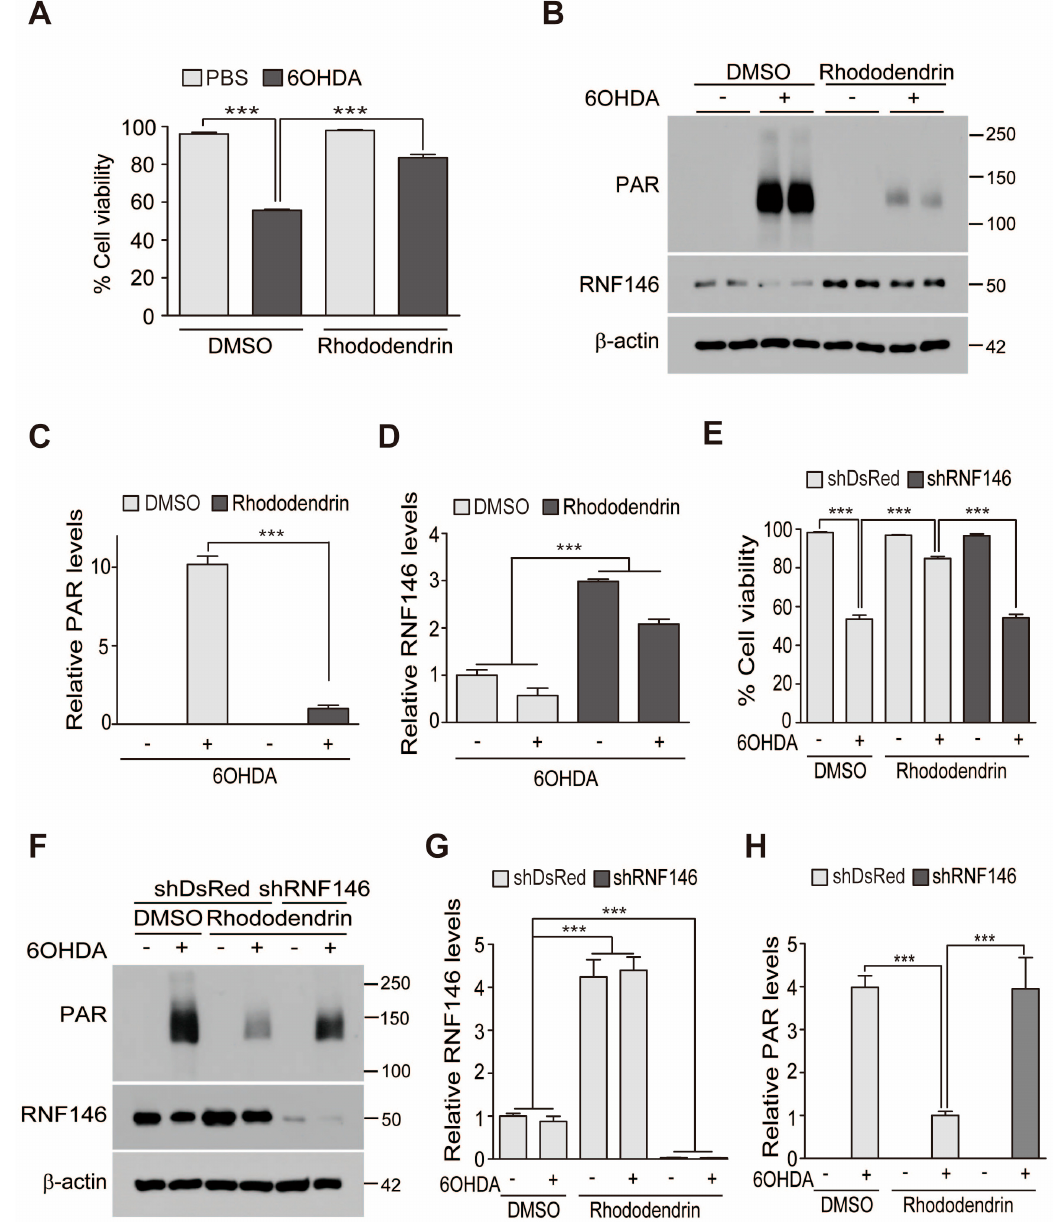
Figure 2. Rhododendrin-induced RNF146 expression protects SH-SY5Y cells from 6-OHDA toxicity. ( A ) Trypan blue exclusion cell viability assay demonstrating that rhododendrin pretreatment (10 µ M, 37 h) increase cell survival after stimulation with 6-OHDA (70 µ M, 16 h) ( n = 6). ( B ) Representative immunoblots showing poly (ADP-ribose) (PAR), and RNF146 expression levels in SH-SY5Y cells challenged with 6-OHDA (70 μ M, 30 min) following pretreatment with rhododendrin (10 μ M, 37 h) or DMSO vehicle as a control. Quantification of relative PAR ( C ) and RNF146 ( D ) expression levels in the experimental groups in panel B. Values are normalized to those of β -actin ( n = 3). ( E ) Trypan blue exclusion cell viability assay demonstrating that rhododendrin protection of